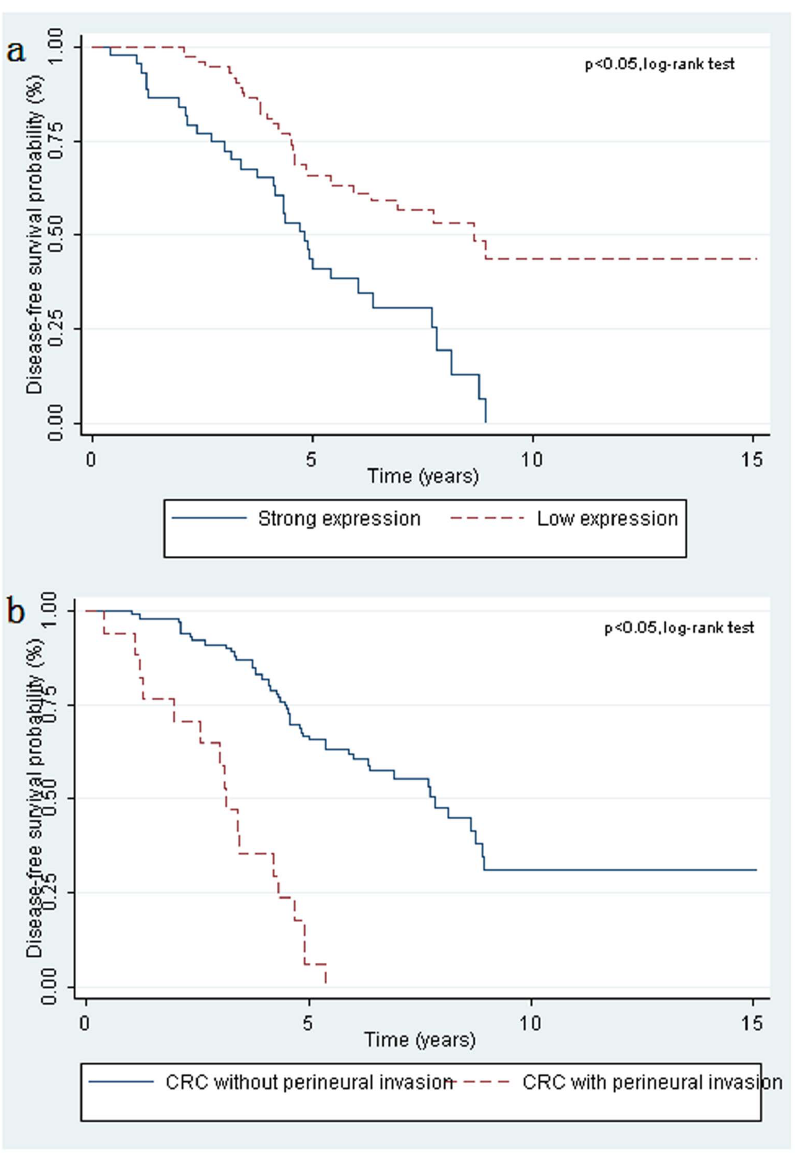
Figure 3. Overexpression of TCF3 was associated with a poor survival rate in CRC. (a) Patients with high TCF3 expression (n=44) showed a significantly poorer prognisis than those with low TCF3 expression (n=74; P , 0.05; log-rank test). (b) Patients with perineural invasion (n=17) showed significantly poorer prognisis than those without such invasion (n=101; P , 0.05; log-rank test).